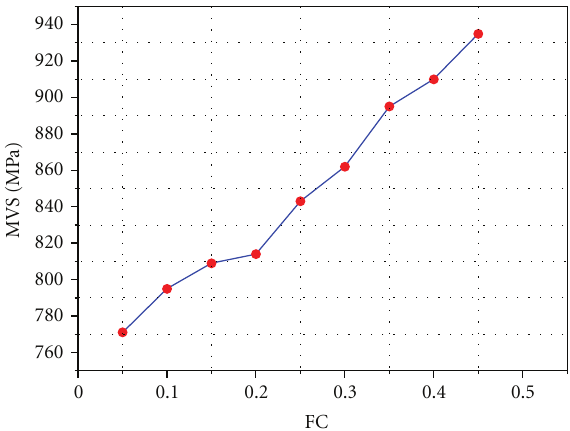
Figure 7: The relationship between sliding friction coe ffi cient and maximum von Mises